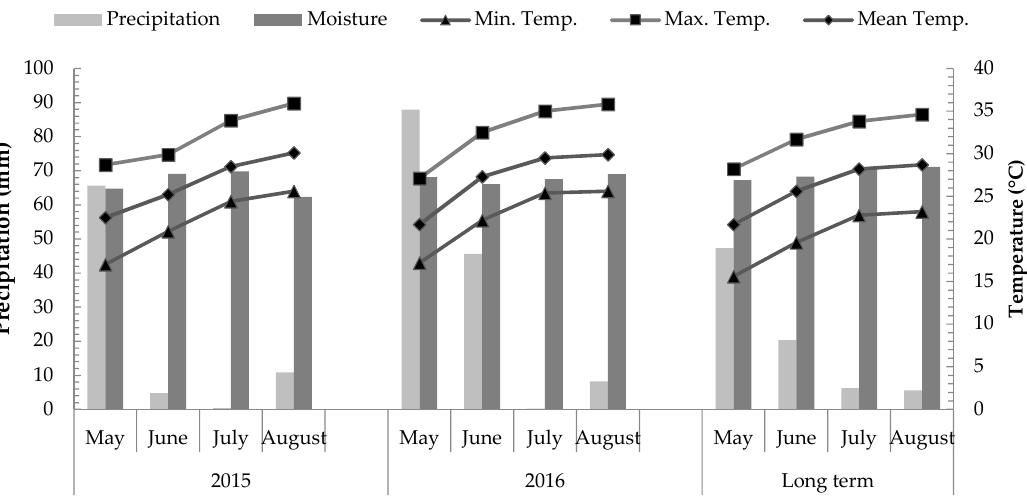
Figure 1. Meteorological data recorded during the field trial and long term (1960–2012). The data were derived from meteorology directorship of Adana, Turkey.